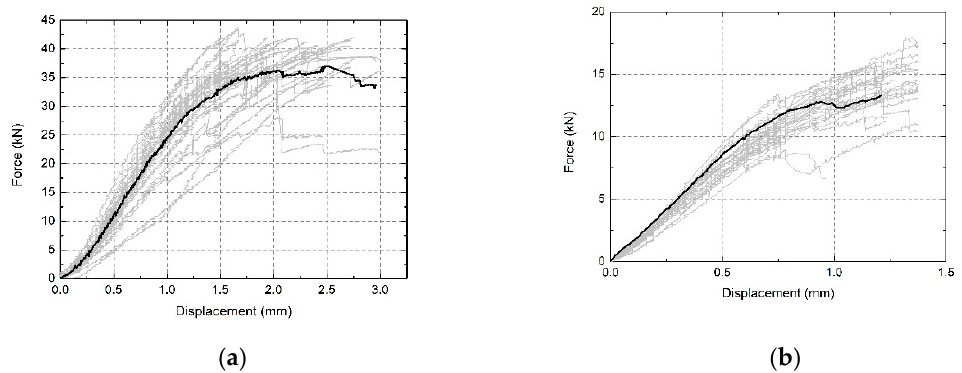
Figure 6. Load–displacement curves of the bond line shear tests, ( a ) surface bonding (Bi) and ( b ) edge bonding (Ei).